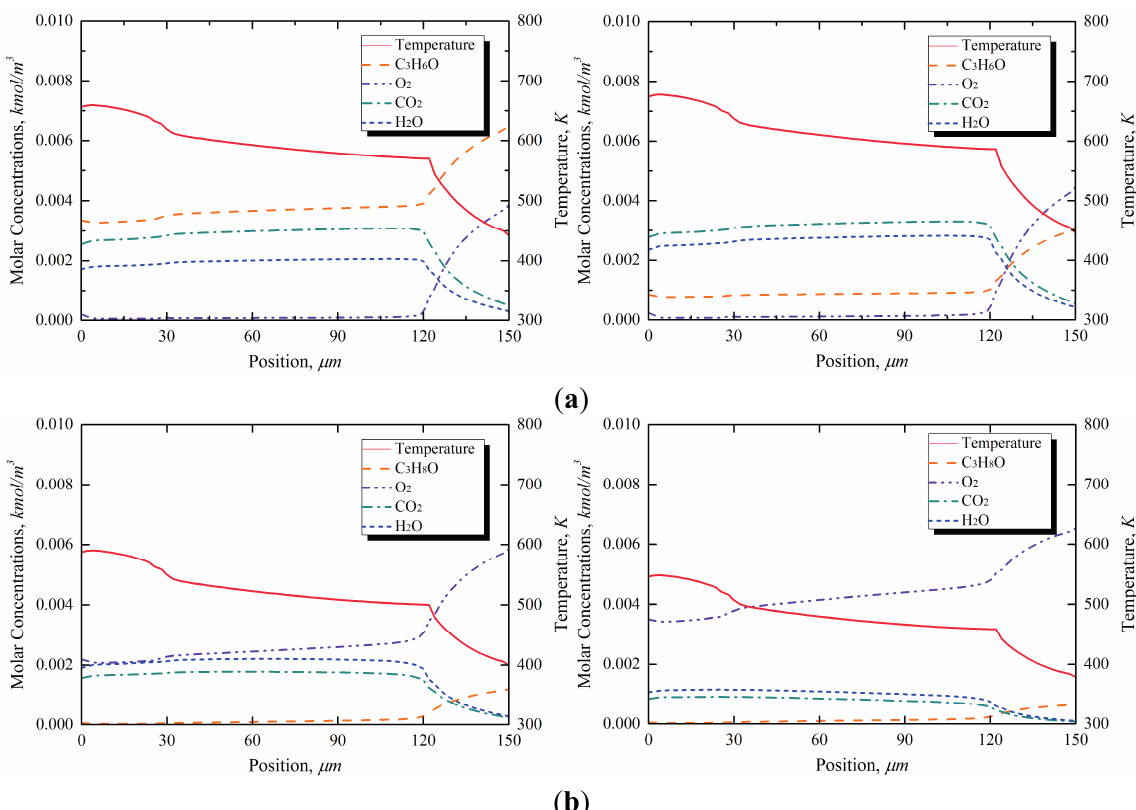
Figure 11. Surface coverage of species and wall temperature profile in different mole fractions (or concentrations) ( a ) acetone (explosive:air = ( Left ) 0.243:0.598 and ( Right ) 0.122:0.694); and ( b ) 2-propanol (explosive:Air = ( Left ) 0.044:0.756 and ( Right )